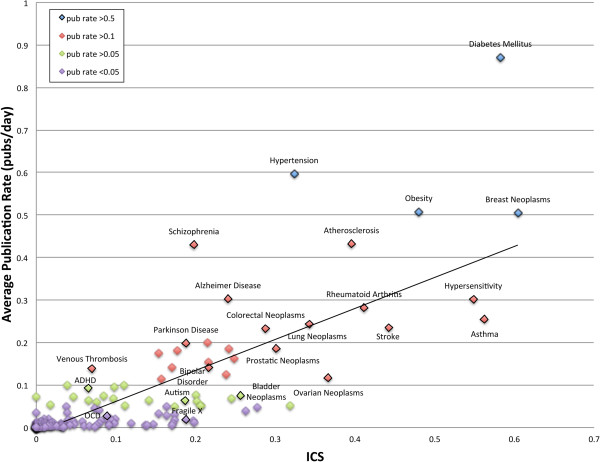
Average rate of publication (publications/day) of disease-specific research fields with various levels of involvement in cooperative research (defined by the ICS). From this figure it is clear that two genetically related diseases publish more often when cross-referencing their gene discoveries (diabetes mellitus and obesity), than when working independently (autism and ADHD) (r2=0.7931).